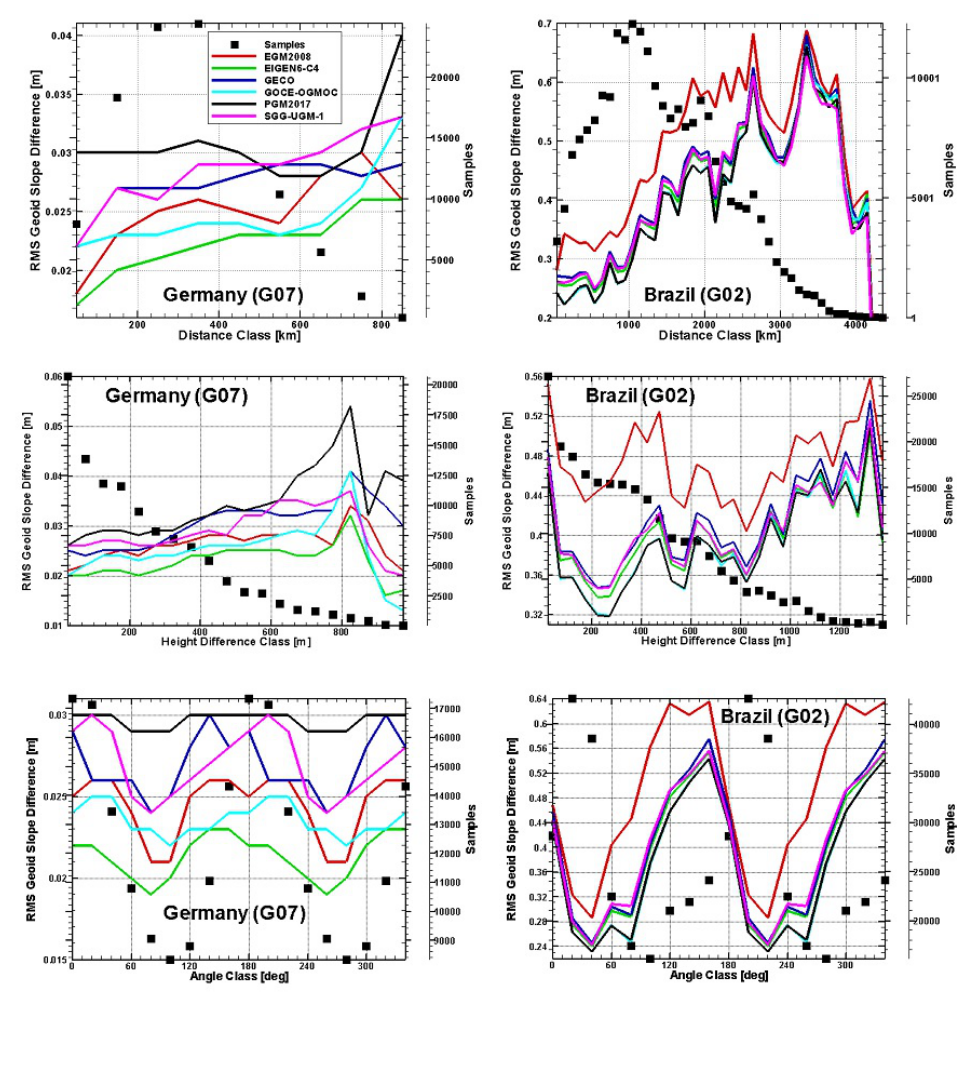
Fig. 5. RMS of geoid slope differences (all in [m]) between global models with full resolution (degree 2190) and GNSS-levelling points in Germany and Brazil. For all differences a planar correction surface was computed and subtracted from the geoid height differences. RMS of differences is shown for specific distance classes (100 km), for height difference classes (50 m) and for orientation classes (20 degrees) (left scale in each sub-figure). Black dots show the number of geoid slope differences per class (right scale in each sub-figure). Top row: RMS for distance classes; Middle row: RMS for height difference classes; Bottom row: RMS for orientation